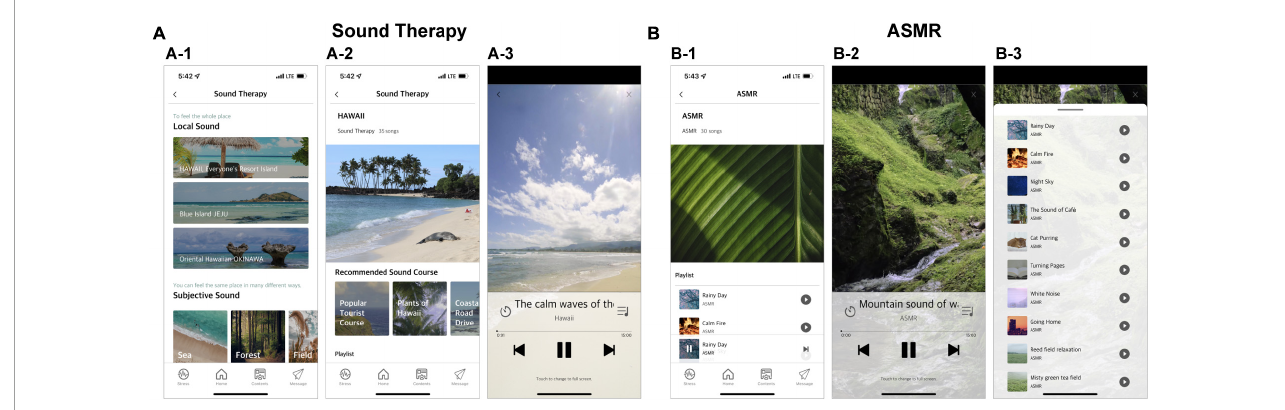
FIGURE6 Screenshots of the relaxation sound module. The module includes two types of sounds ( A : “Sound Therapy” and B : “ASMR”). Participants can select a region of natural scenery they would like to hear and chose from the curated “Sound therapy” list (A-1). Various types of videos are prepared for each region, and participants can select from them (A-2). Panel (A-3) shows the video playback screen. Participants can click the video they want from the list presented in the ASMR component (B-1). Panel (B-2) shows the screen where the video is played in “ASMR.” Both “Sound Therapy” and “ASMR” can be accessed as a list from the playback screen (B-3). The content was presented in Korean, but the examples in this figure are presented in English to aid understanding for international readers.